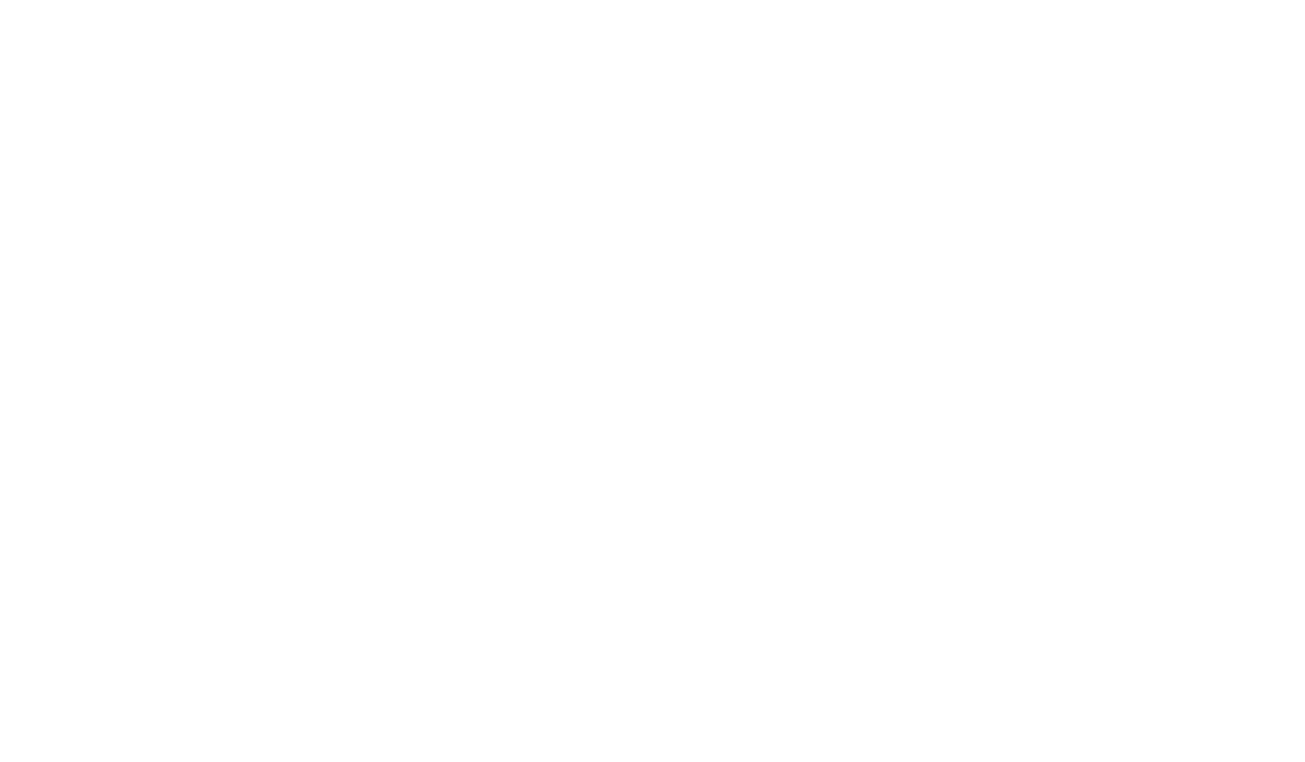
FIGUREA8 | RP-HPLC-ESI-MS (Orbitrap) base peak chromatograms of xylem sap of plants challenged with 1000 μ g/kg arsenate with (A) the whole mass range ( m / z 100–2000), (B) the mass range m /